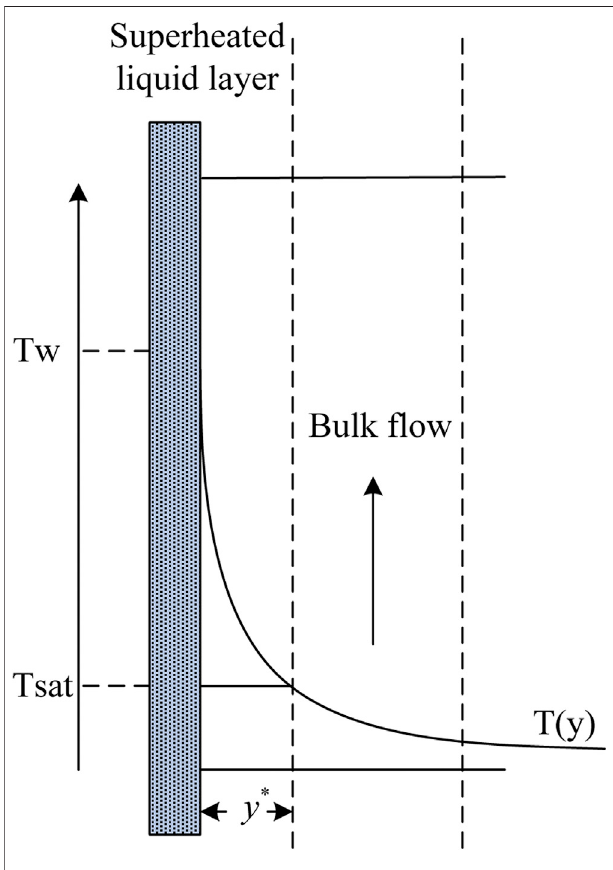
FIGURE 4 | Schematic diagram of superheated liquid layer thickness.